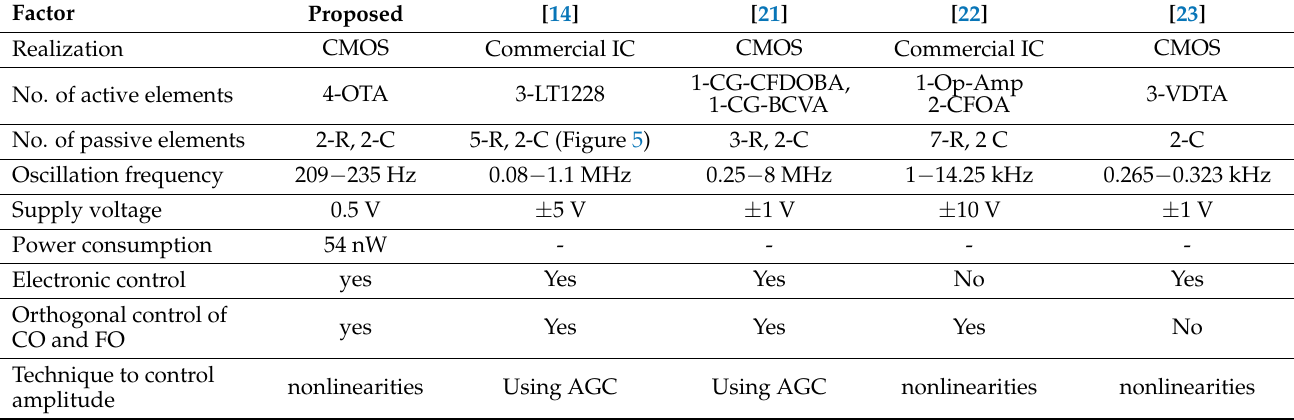
Table 3. Comparison of the proposed shadow oscillators with previous